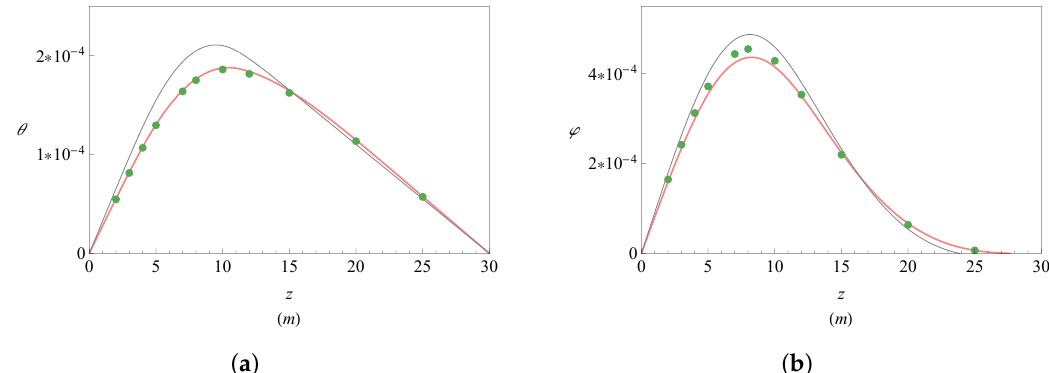
Figure 14. Comparison among deflections: ( a ) twist angle, ( b ) distortion; Fourier ( N = 50 terms, thick red lines), Finite Element Method (FEM) (bullets), and uncoupled differential equations (thin gray lines).